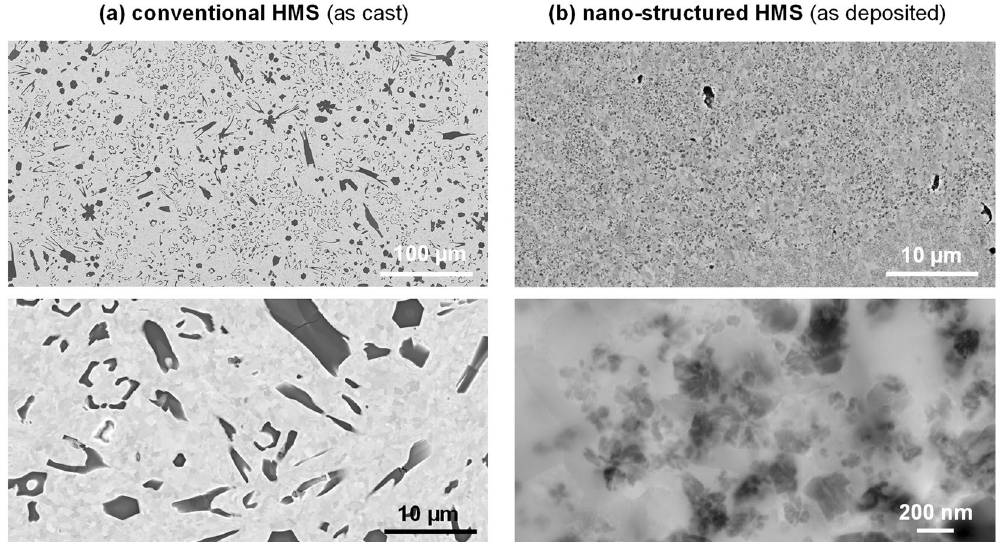
Figure 3. Microstructure characterisation results as SEM BSE and STEM BF images of High Modulus Steels after the primary synthesis by ( a ) conventional casting and ( b ) spray-forming.